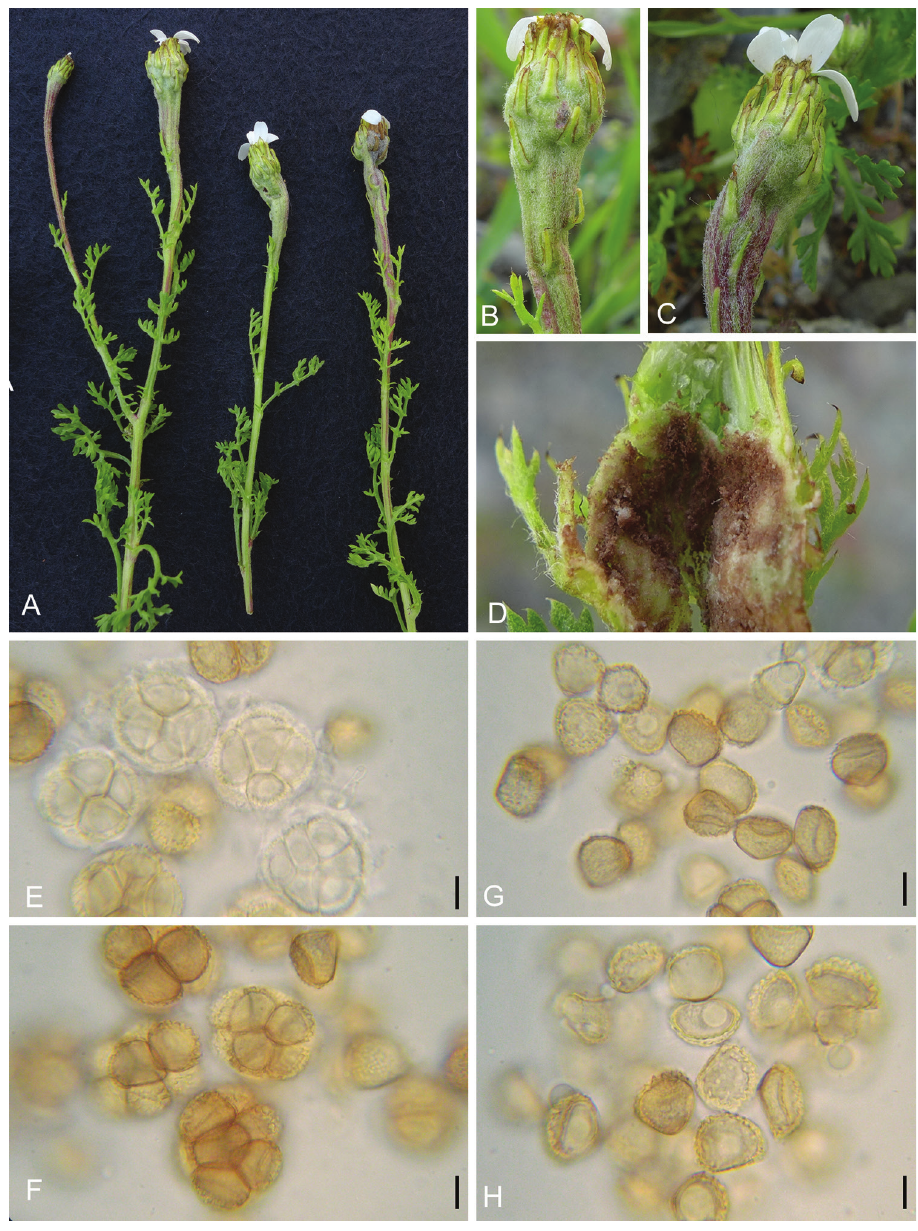
Figure 2. Sori, spore balls and spores of Thecaphora anthemidis on Anthemis chia (GLM-F112531) ( A–H ), A habit B–C swollen flower heads and peduncles D dissected flower head with reddish granular powdery spore ball mass E young spore balls F mature spore balls G–H single spores. Scale bars: 10 µm. balls. Further, Th. arnicae (spore balls comprised of up to 25 spores), Th. californica (6–20 spores) and Th. solidaginis (8 to 50 or more spores) have larger spore balls with larger numbers of spores than Th. anthemidis . The spores of Th. cuneata are radially